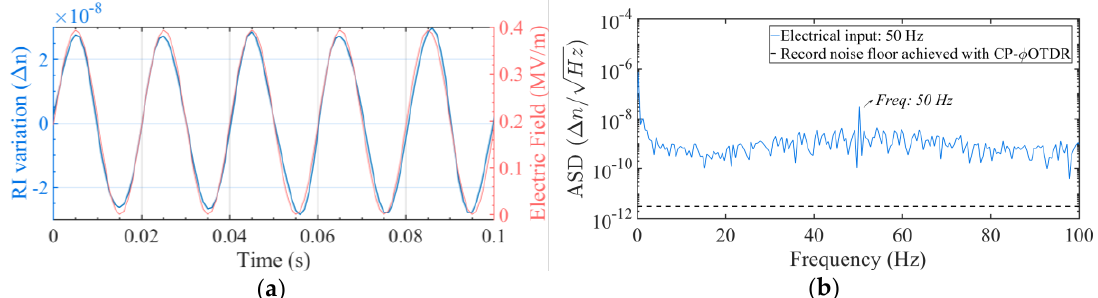
Figure 6. ( a ) Measured RI variation for a periodic electric field applied to a poled fiber (50 Hz, between 0 V/m and ~0.39 MV/m), via the built-in electrodes, represented in the time-domain (blue line); expected variation (proportional to applied E; see discussion below) is also presented for comparison (red line). ( b ) Measured RI variation represented in the frequency domain (blue line). The record noise floor achieved with CP-φOTDR in standard SMF is also represented [black dashed line in ( b )] to contextualize the full potential of the technique [24], although it is not aimed at a direct comparison with the presented results.